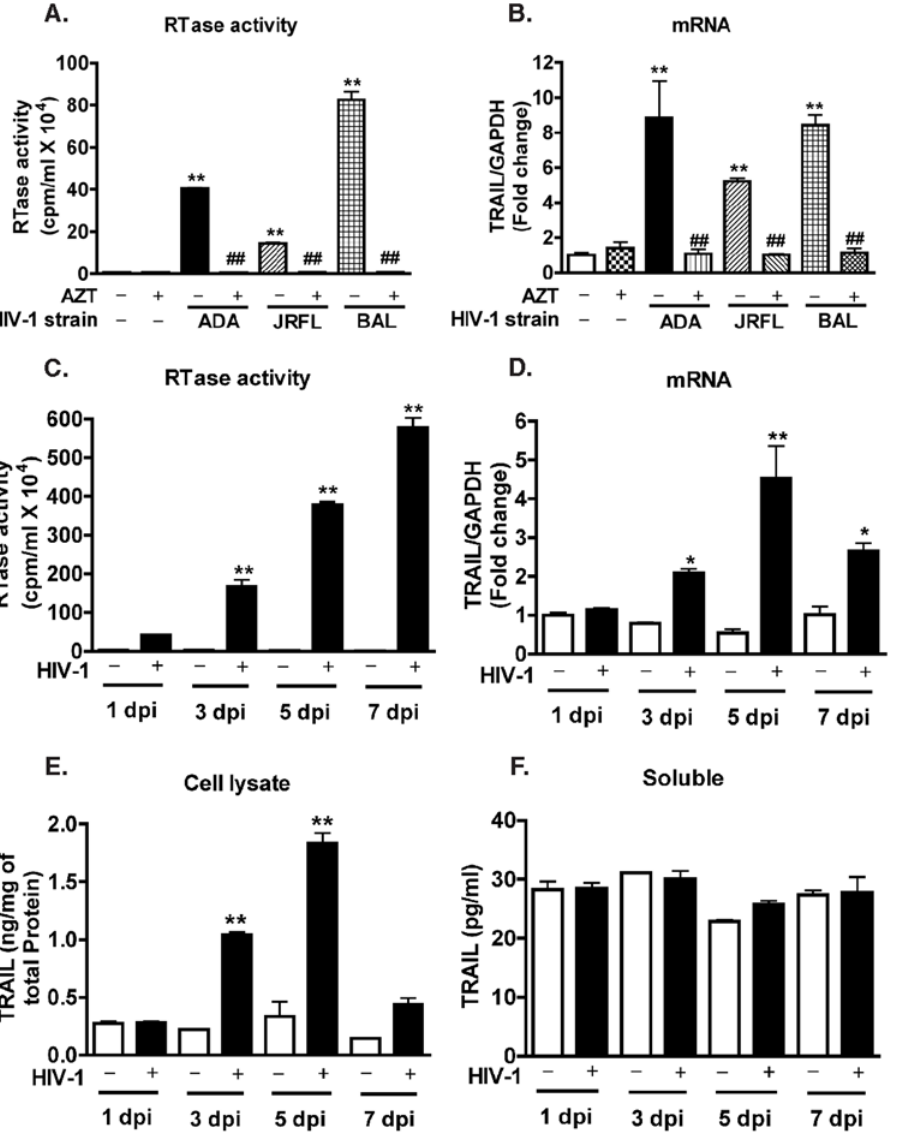
Figure 1. TRAIL expression in human macrophages increases when infected with HIV-1. A–B. Human MDM were infected with HIV-1 ADA , HIV-1 JR-FL , or HIV-1 BAL in the presence or absence of AZT. Cells (total RNA) and culture supernatants were collected 5 days after infection. A. Supernatants were tested for HIV-1 RTase activity. B. TRAIL expression was determined by real-time RT-PCR. Results were normalized to GAPDH expression and shown as fold change over control. ** indicates p , 0.01 when compared to control; ## indicates p , 0.01 when compared to corresponding HIV-1 group. C–F. Human MDM were infected with HIV-1 ADA . Samples were collected 1, 3, 5, and 7 days after infection. C. Supernatants were tested for RTase activity. D. TRAIL expression was determined by real-time RT-PCR. E–F. TRAIL protein levels in cell lysate (E) and culture supernatants (F) were measured by TRAIL ELISA. Open bars represent control MDM and solid bars represent HIV-1-infected MDM. ** indicates p , 0.01, * indicates p , 0.05 when compared to the corresponding control. Data are representative of three donors.